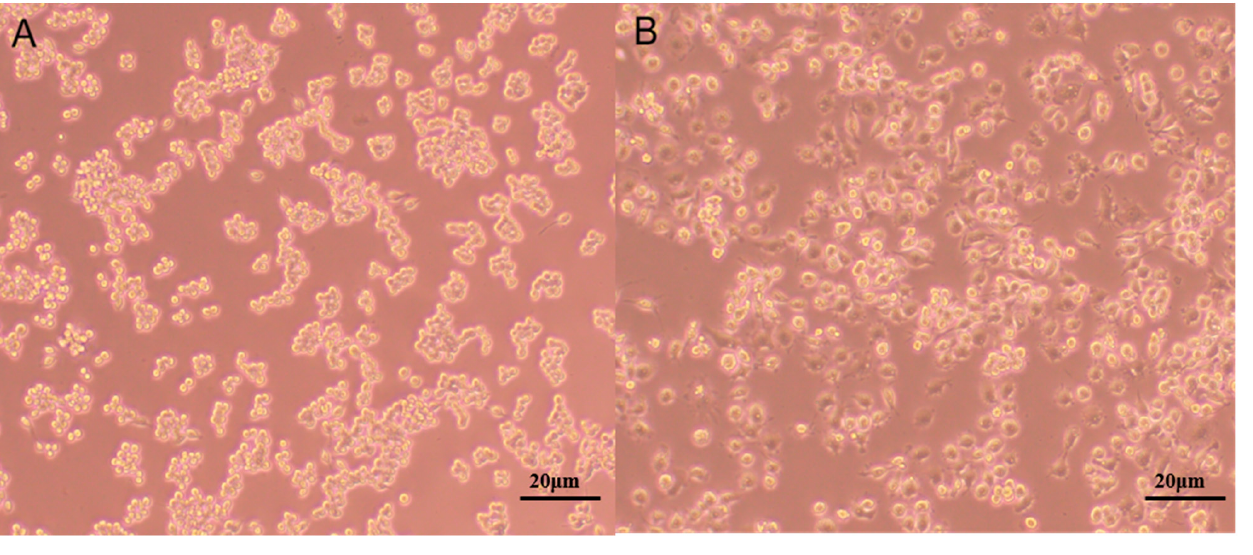
Figure 5. Micrographs of RAW 264.7 murine macrophages treated without LPS ( A ) or with LPS ( B ).